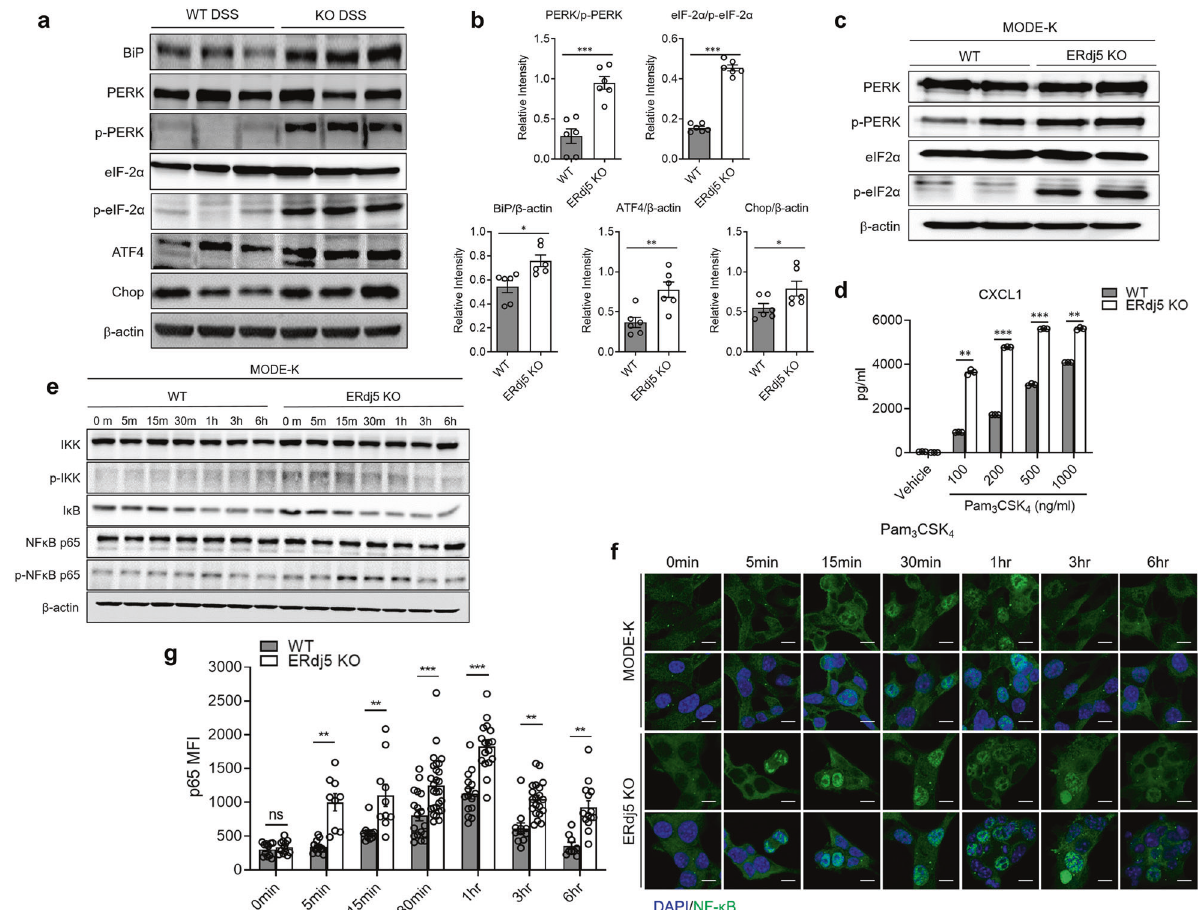
Fig. 5 ERdj5 de fi ciency causes ER stress and in fl ammation mediated by NF- κ B activation. a Expression pro fi le of ER stress-related proteins in the colons of WT or ERdj5- KO mice treated with DSS ( n = 6 per group). b Relative band intensities are expressed as the mean ± SEM. c ER stress proteins in ERdj5- KO MODE-K cells altered by the CRISPR/Cas9 system. d The level of CXCL1 in ERdj5- KO MODE-K cells after Pam 3 CSK 4 treatment (100, 200, 500, and 1000 ng/ml) for 6 h ( n = 3 per group). e The protein expression of NF- κ B pathway factors in MODE-K cells treated with Pam 3 CSK 4 (1 µg/ml) for 0, 5, 15, 30, 60, 180, and 360 min. f Nuclear translocation of NF- κ B/p65 in ERdj5- KO MODE-K cells at the indicated time points after Pam 3 CSK 4 treatment (1 µg/ml). f Immuno fl uorescence image (×200, scale bar 10 µm). g The mean fl uorescence intensity of NF- κ B/p65 (green) is shown ( n = 9~27 per group). The data are representative of three independent experiments, and the values are expressed as the mean ± SEM. * P < 0.05, ** P < 0.01, *** P < 0.001; Student ’ s t test